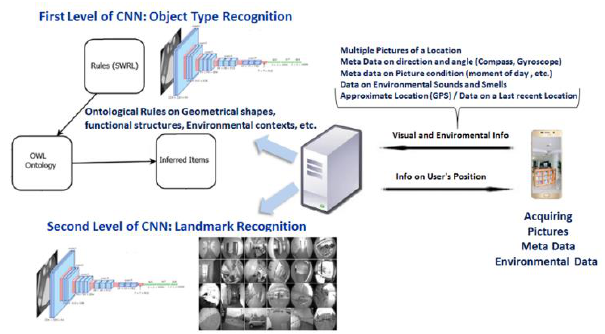
Figure 5 . Overall architecture of the two-phase CNN-based